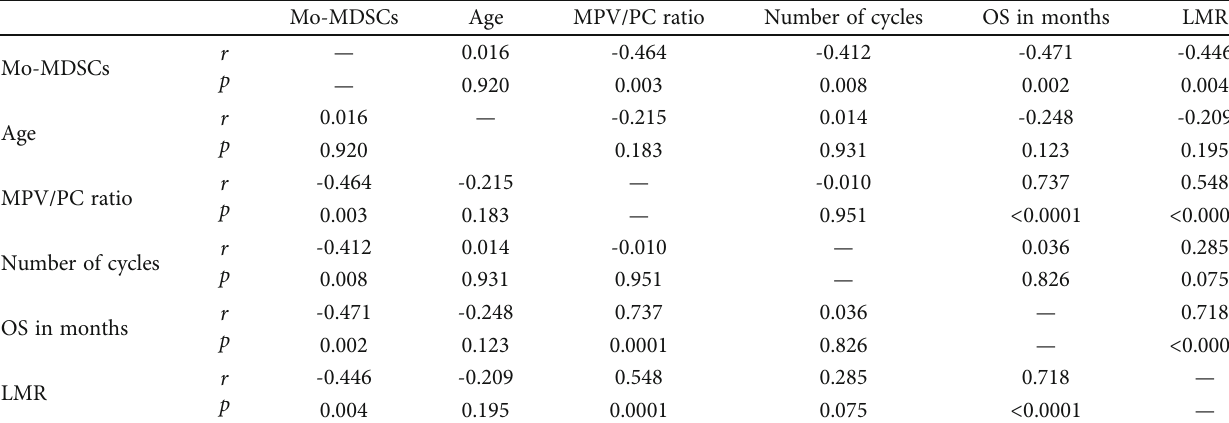
Table 4: Correlation between Mo-MDSCs and survival.